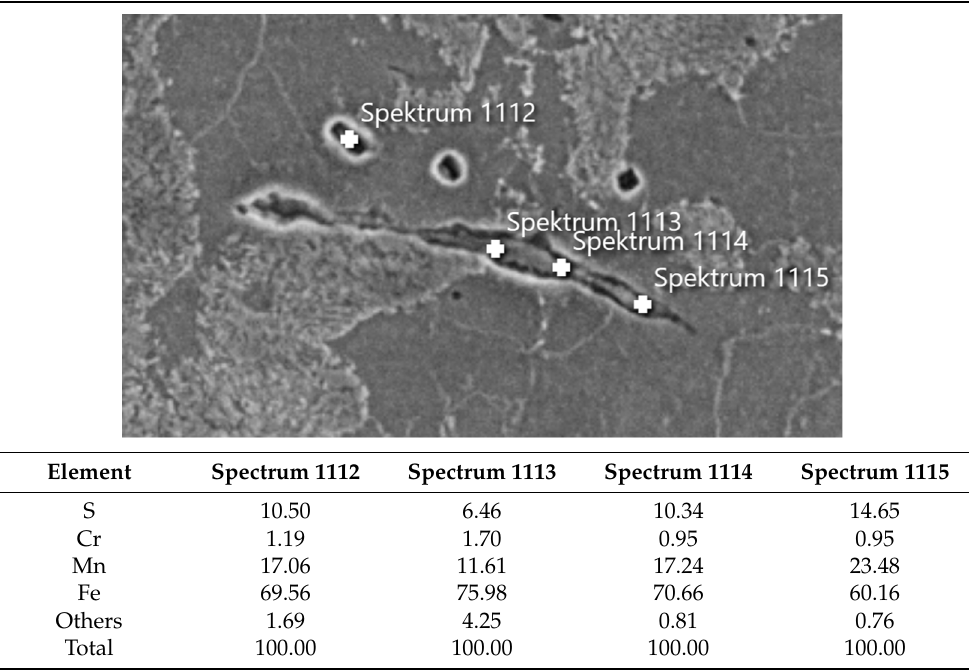
Figure 5. Elemental analysis of the modified 16MnCrS5 steel specimen using EDS to identify the inclusions (the red dotted line represents the line of measurement). The inclusion shows a major concentration of Mn and S; therefore, it is classified as an MnS inclusion. Table 2. Chemical analysis of inclusion at different points, confirming MnS. The units of the measurement are in mass, %.